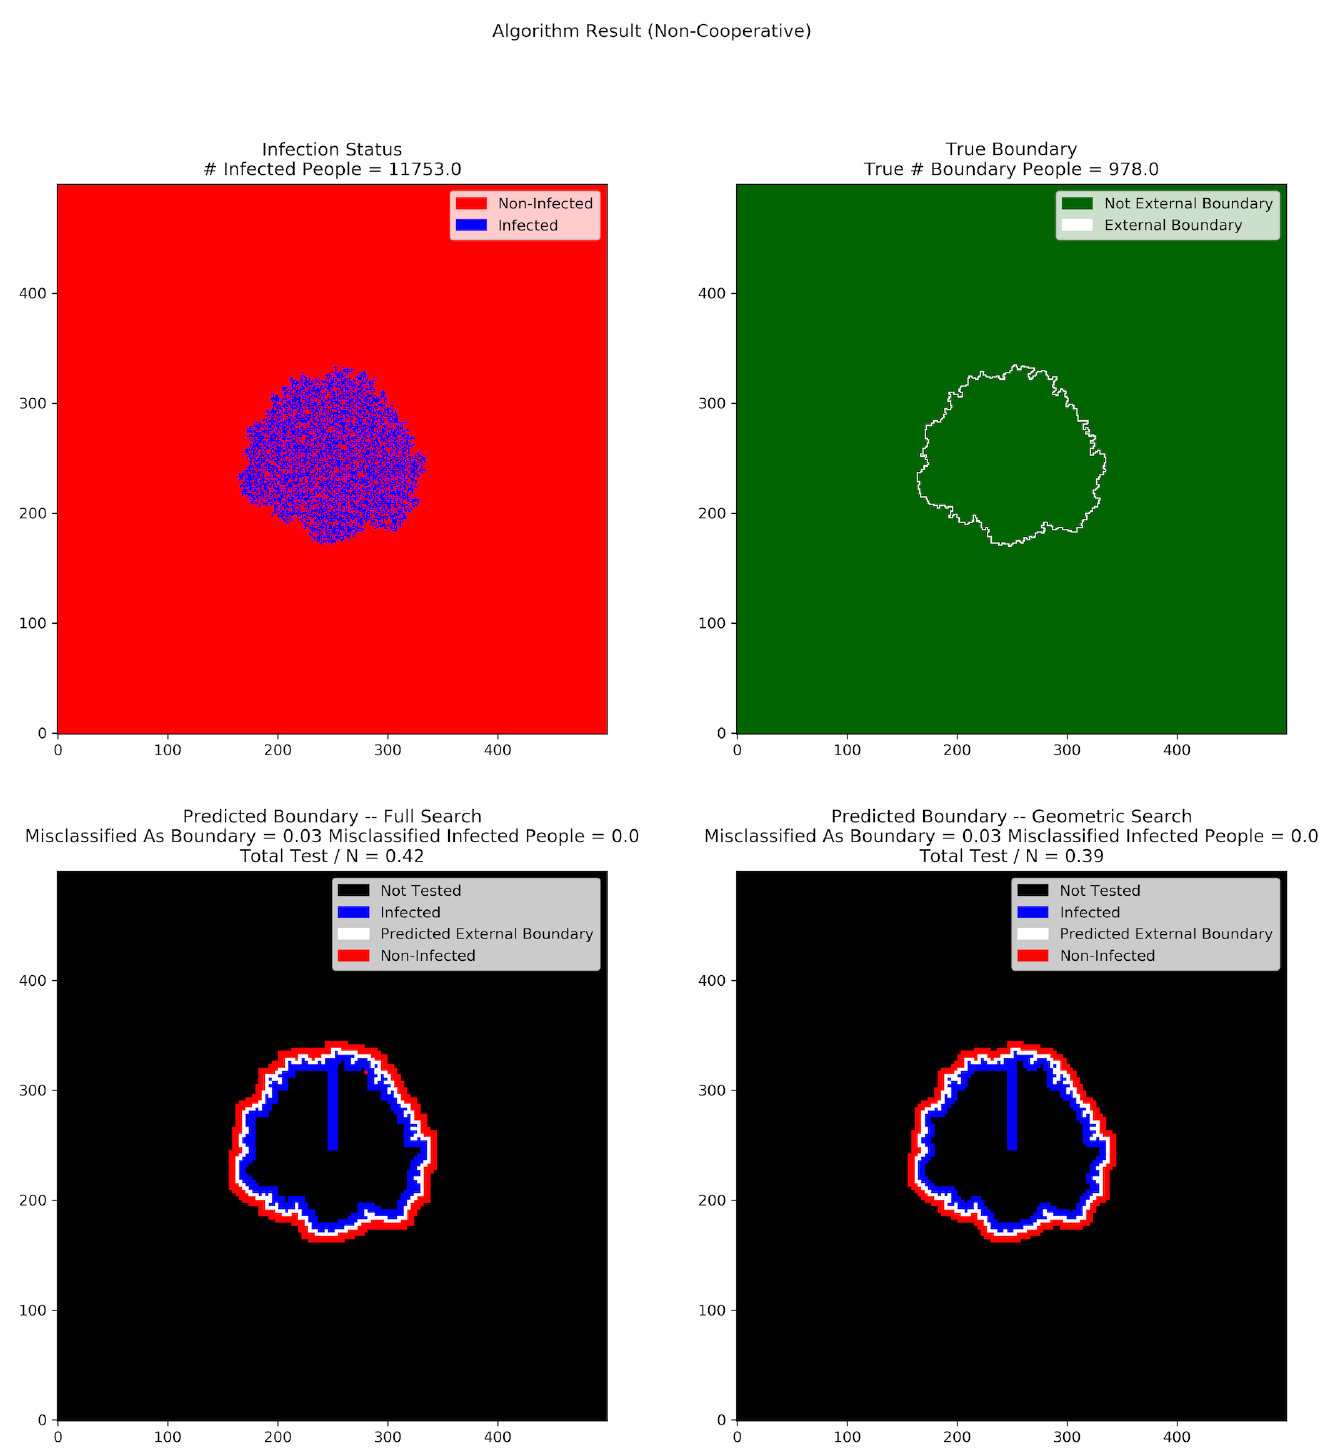
Figure 4. Population = 250,000 Non-cooperative Rate = 0.333. Duration = 200 Infection Probability = 0.1. N: number of people inside and containing the external